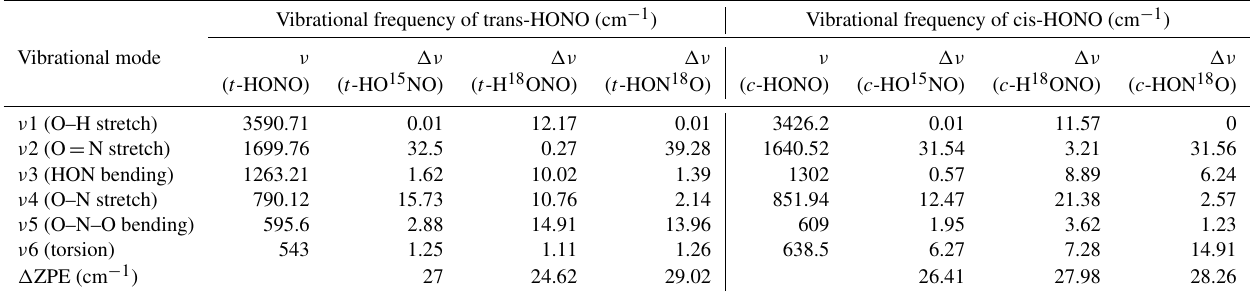
Table B1. Vibrational frequencies of HONO and its isotopologues. Vibrational frequency of trans-HONO (cm − 1 ) Vibrational frequency of cis-HONO (cm − 1 ) Vibrational